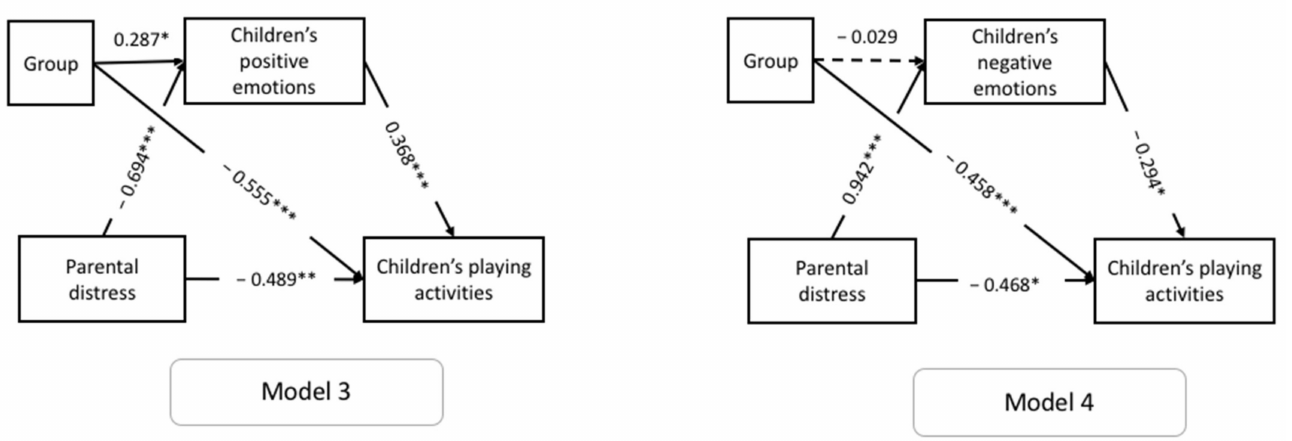
Figure 3. Model 3 and 4 testing the expected mediation relationships, with the group as a covariate. * p < 0.05; ** p < 0.01; *** p <